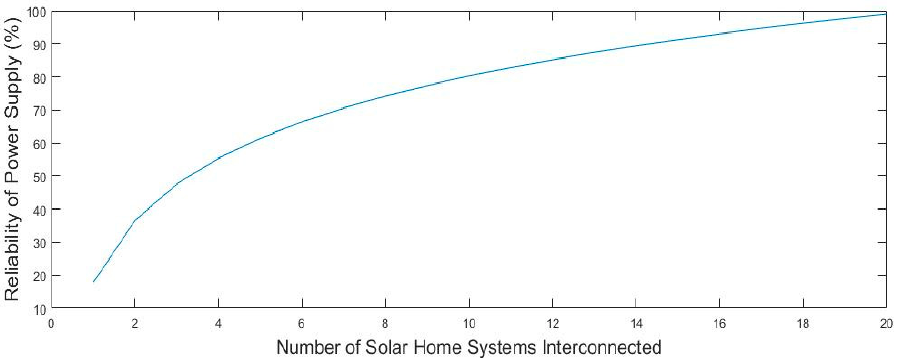
Figure 10. Reliability of power supply and number of prosumers in the microgrid.